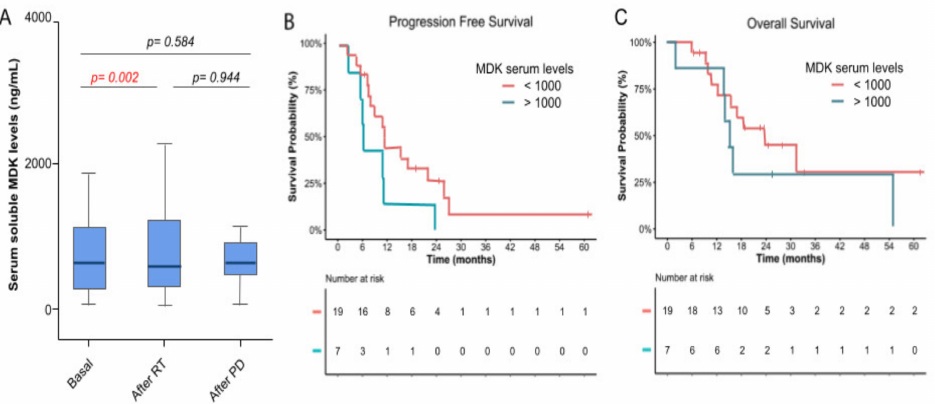
Figure 4. Correlation between MDK serum levels and efficacy. ( A ) Soluble MDK serum levels were quantified by ELISA at 3 timepoints throughout the study period: at baseline, after the concomitant phase of treatment, and after unequivocal progression of the disease. MDK levels are represented as a box plot with the median (dark line), the 25% and 75% quartiles (box), and 95% CI interval (cap lines). p -values were obtained by paired t-test. ( B ) PFS estimated by Kaplan–Meier stratified by the serum MDK levels. ( C ) OS estimated by Kaplan–Meier stratified by the serum MDK